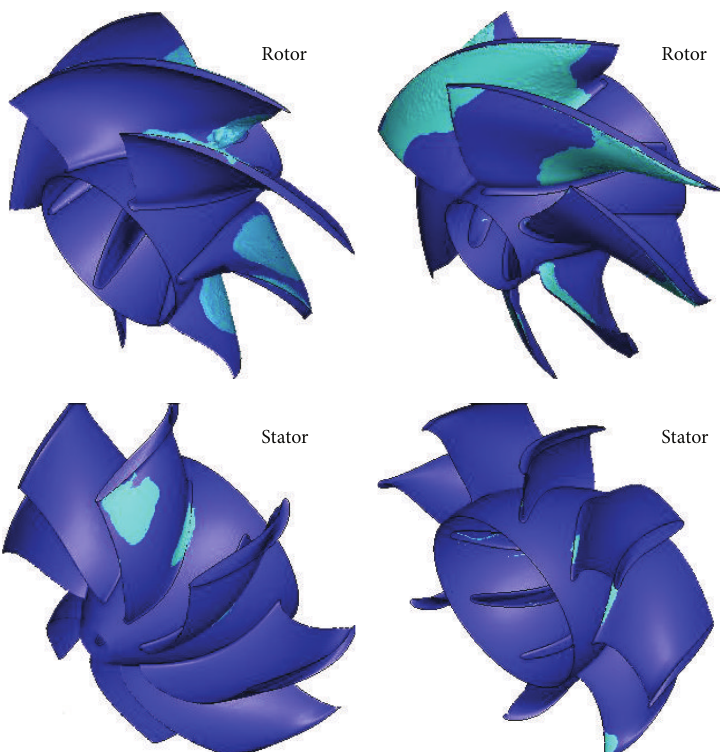
Figure 14: Isosurfaces of fluid cavitation volumes corresponding to a volume fraction of vapor of 20% on the rotor and stator blades and hub.